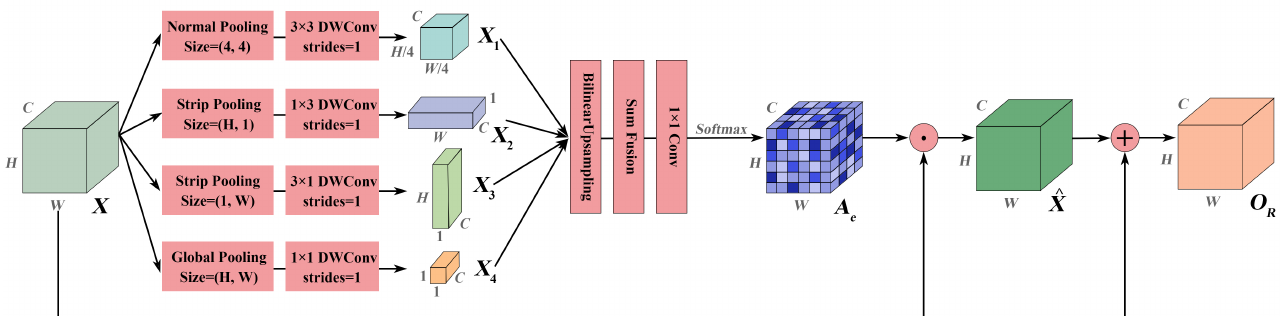
Figure 2. Attention Recalibration Module. Four parallel pathways equipped with different types of pooling operations are implemented to generate multi-scale semantic descriptors of the input feature X , and then a 3D recalibration attention map A e is excited for enhancement and the final output O R is yielded by the element-wise addition of X and the enhanced feature ˆ X